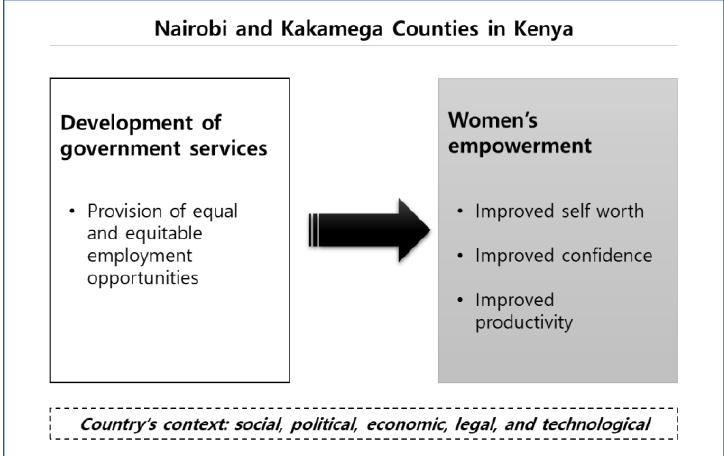
Figure 1: Conceptual Framework (Source: Authors’ depiction)